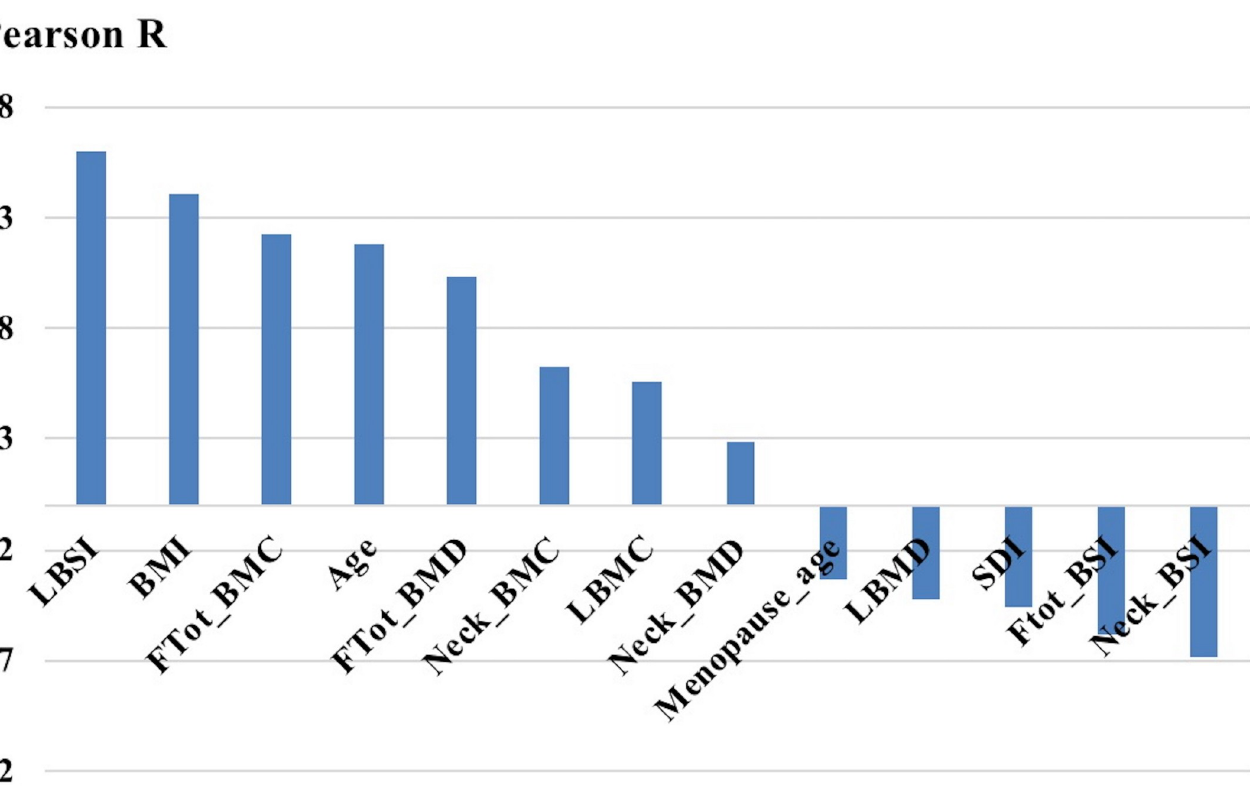
Fig 2. Linear correlation index between patients characteristics and the presence of a further